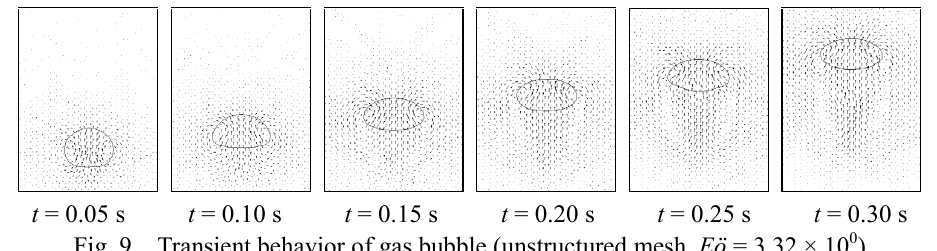
Fig. 9 Transient behavior of gas bubble (unstructured mesh, Eö = 3.32 × 10 0